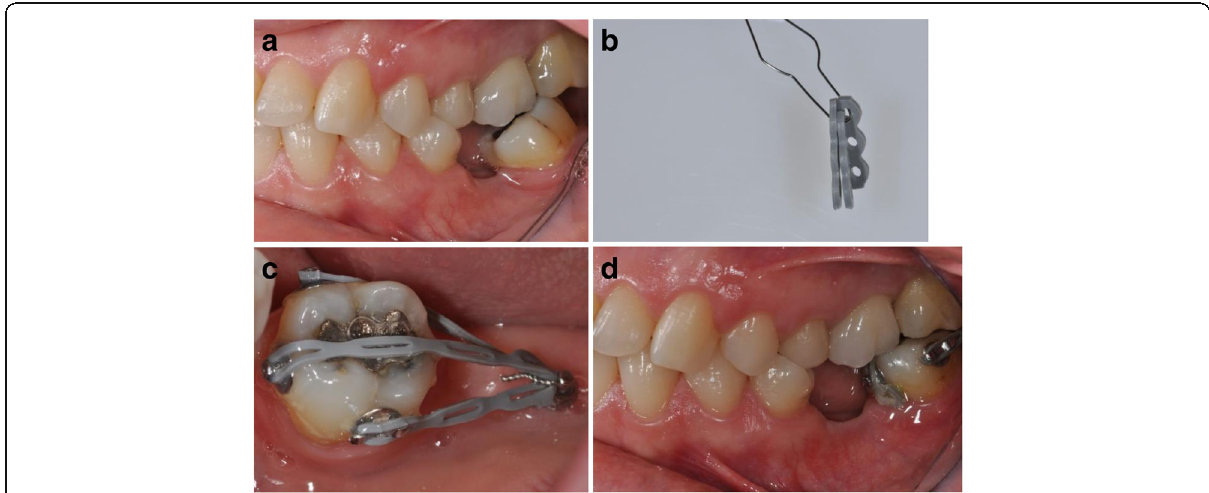
Fig. 7 Uprighting of a mesially inclined #37 with a miniscrew implant and a G-chain. a Patient with missing lower first molar and mesially inclined lower left second molar before treatment. b A ligature wire connecting the segments of the elastic chain. c G-chain tied to miniscrew with ligature wire and activated by attaching free ends of chain segments to bonded buttons. d Clinical situation after 5 months of traction (from Greco et al. [25], with kind permission of Journal of Clinical